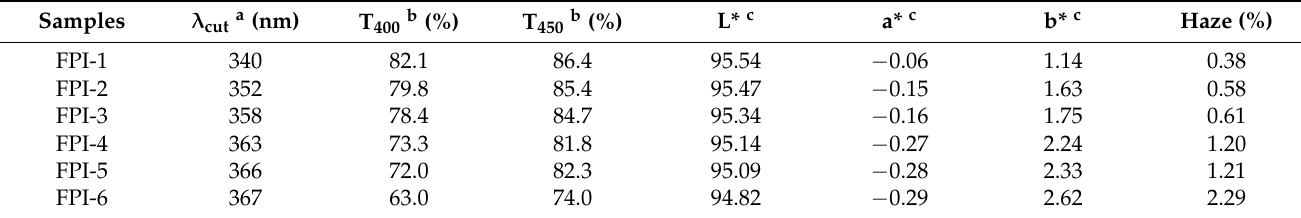
Table 3. Optical properties of the FPI